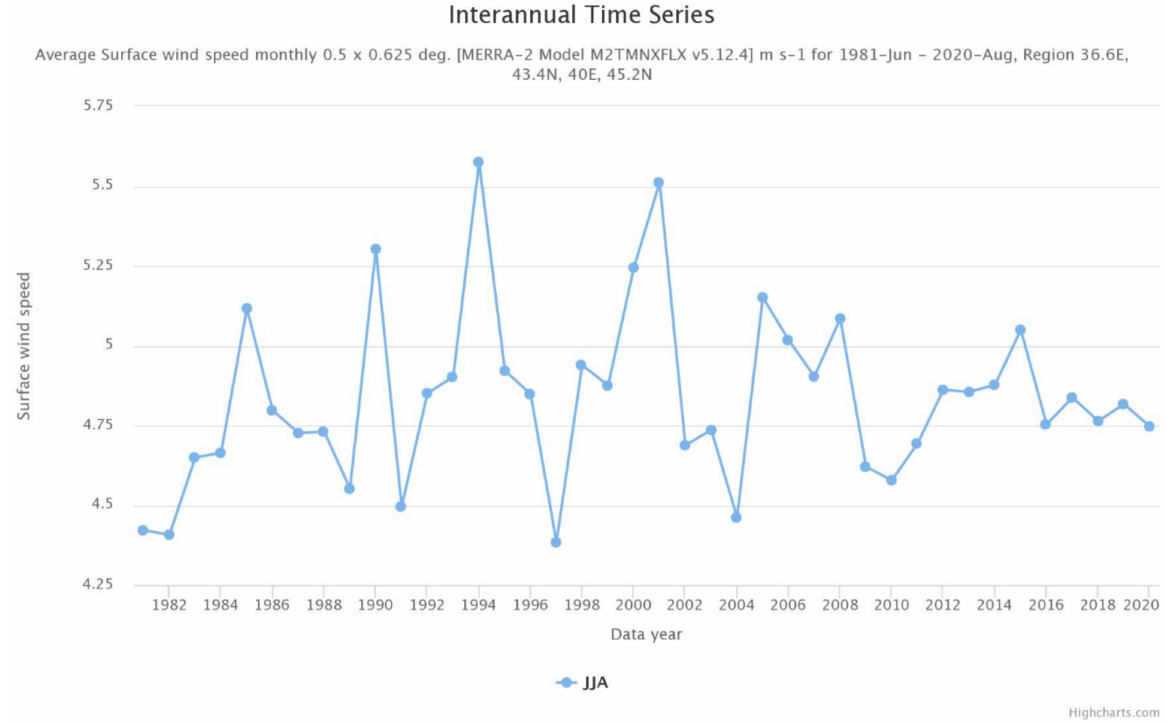
Figure 13. Interannual variability of the wind speed (m/s) in the northeastern Black Sea in summer from 1981–2020 based on the MERRA-2 M2TMNXFLX v5.12.4